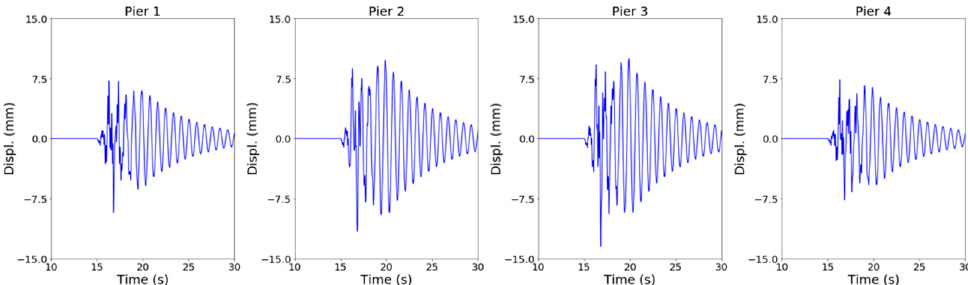
Figure 9. Lateral displacement time histories at the top of each pier.